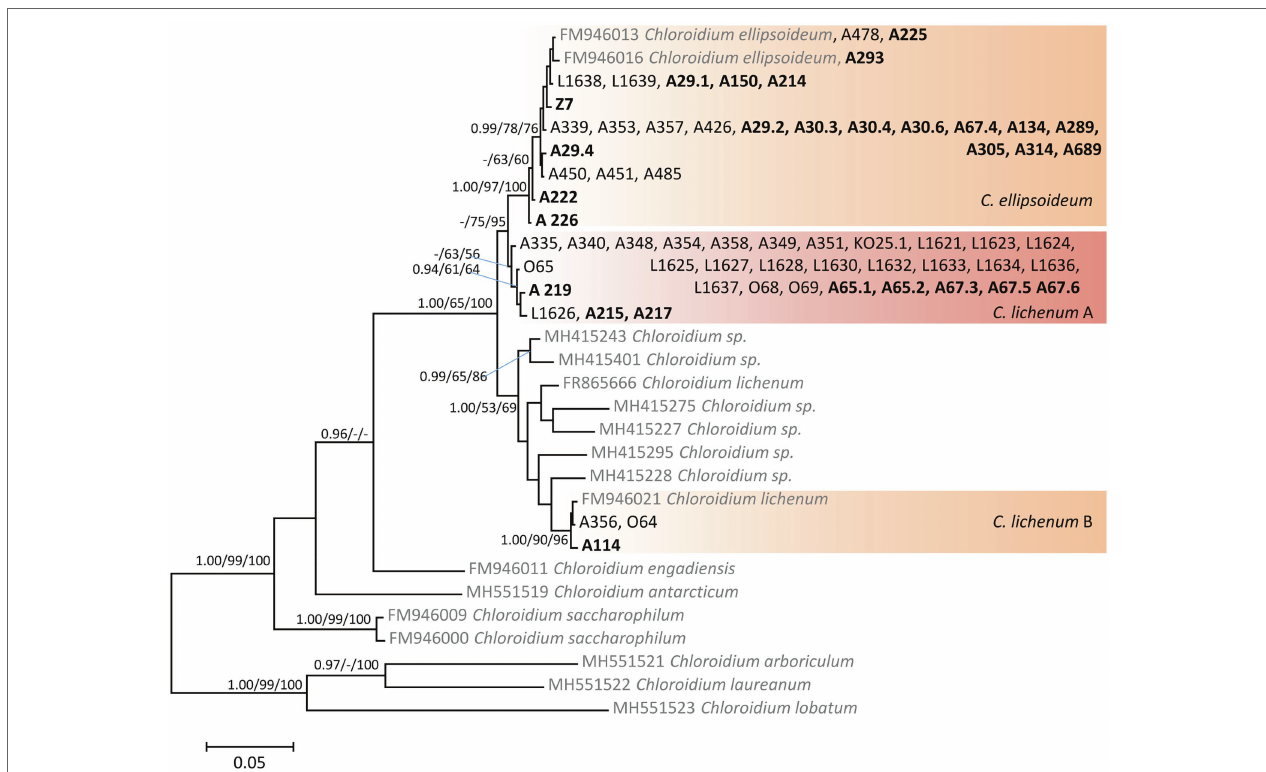
FIGURE 3 | Phylogenetic hypothesis (unrooted tree) of Chloroidium resulting from Bayesian analysis of ITS rDNA. Values at the nodes indicate the statistical supports of Bayesian posterior probability (left), maximum-likelihood bootstrap (middle) and maximum parsimony bootstrap (right). Scale bar shows the estimated number of substitutions per site. Newly obtained sequences are marked in bold, reference sequences from GenBank are in grey.